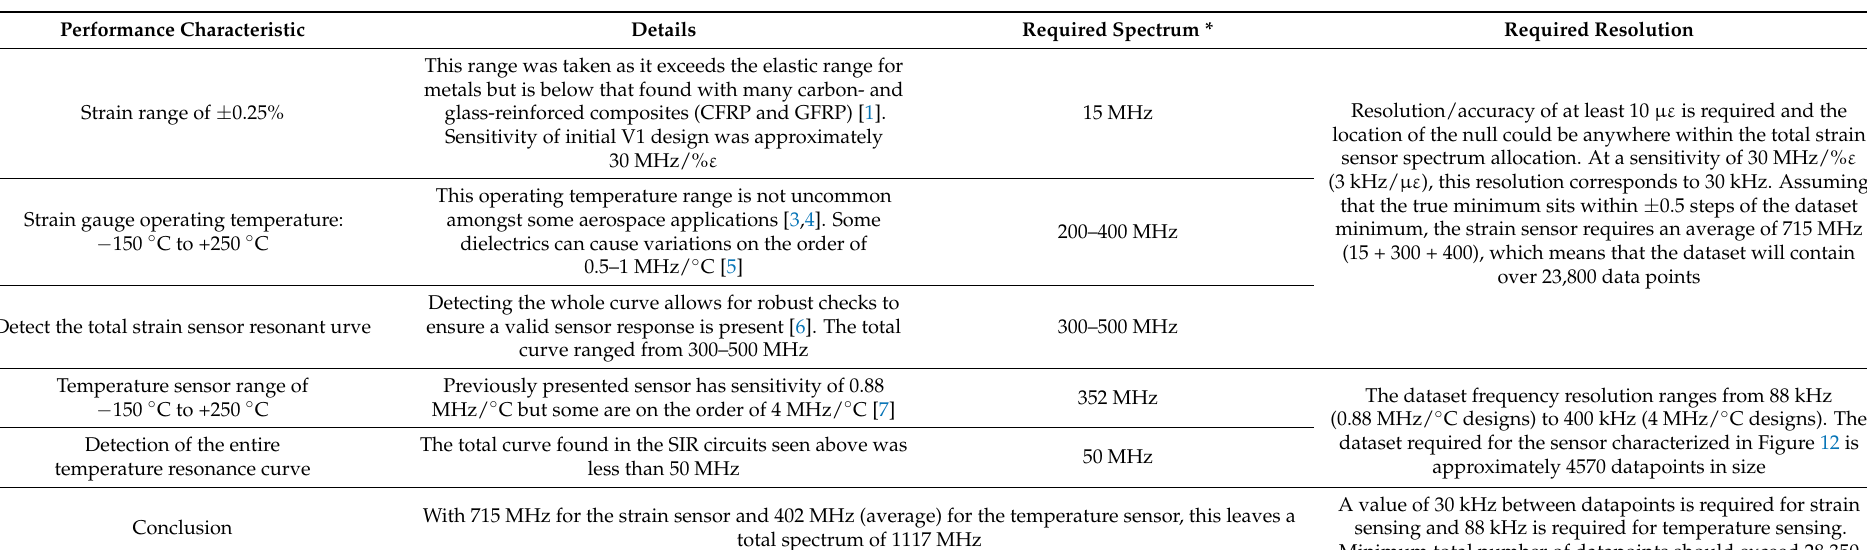
Table 2. Spectrum requirements for sensor